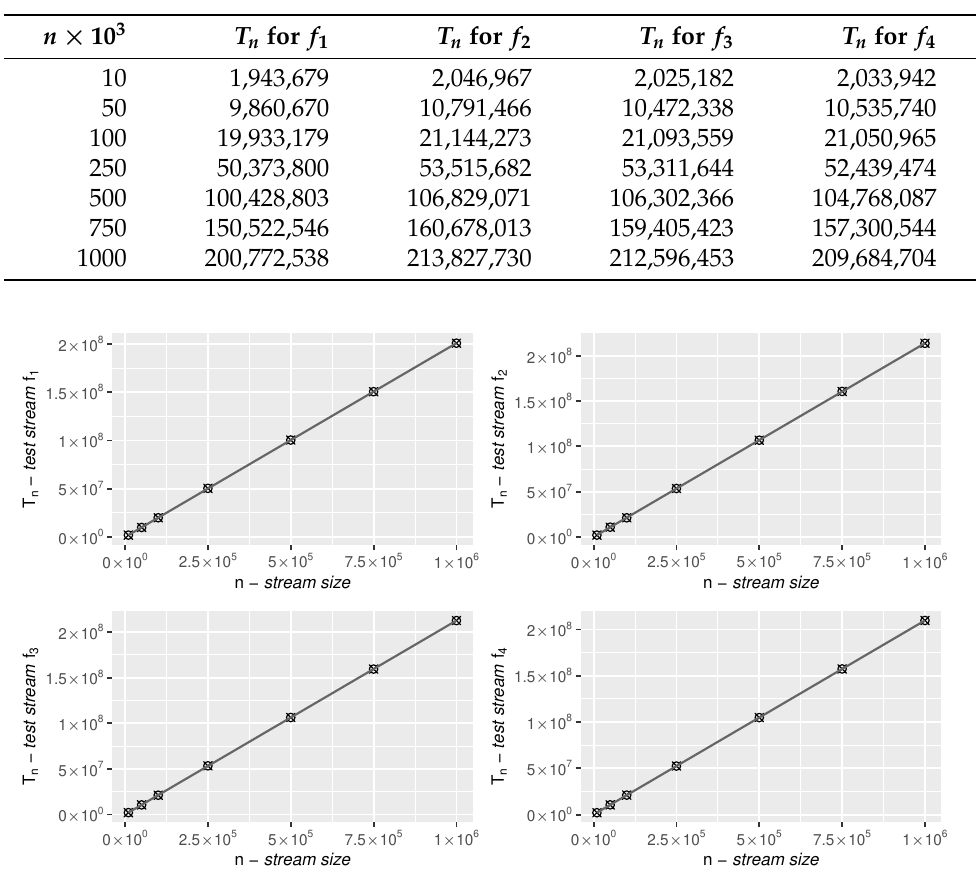
Figure A1. As Table A1, but in graphical form. Table A2. The algorithm time complexity analysis: linear regression ( T n = A n + b